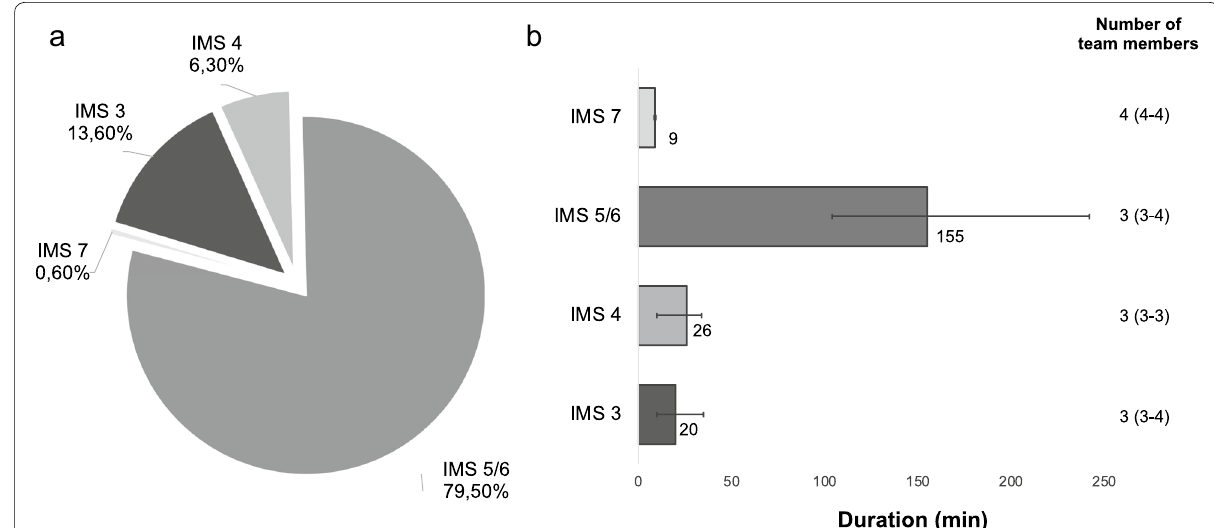
Fig. 1 Percentage, duration and team resources according to different levels of active mobilisation (IMS 3–7). Detailed analysis of a the percentage of each level of mobilisation of all mobilisation units ( n 332), and b duration of different levels of mobilisation and the respective number of team = members used for mobilisation. IMS ICU mobility scale, data presented as percent (%) and median